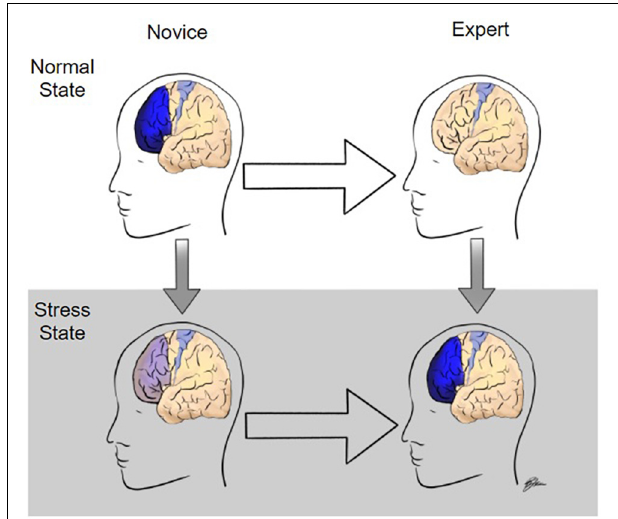
FIGURE 3 | Modulation of prefrontal cortex activity during surgery as a function of expertise and stress level. In the normal state, when performing surgical tasks, novices have high levels of prefrontal cortex (PF) activation whereas experts activate only the motor cortex required to perform the task. Under stressful conditions, such as high temporal demand, experts have increased PFC activation whereas PFC activation is significantly diminished in